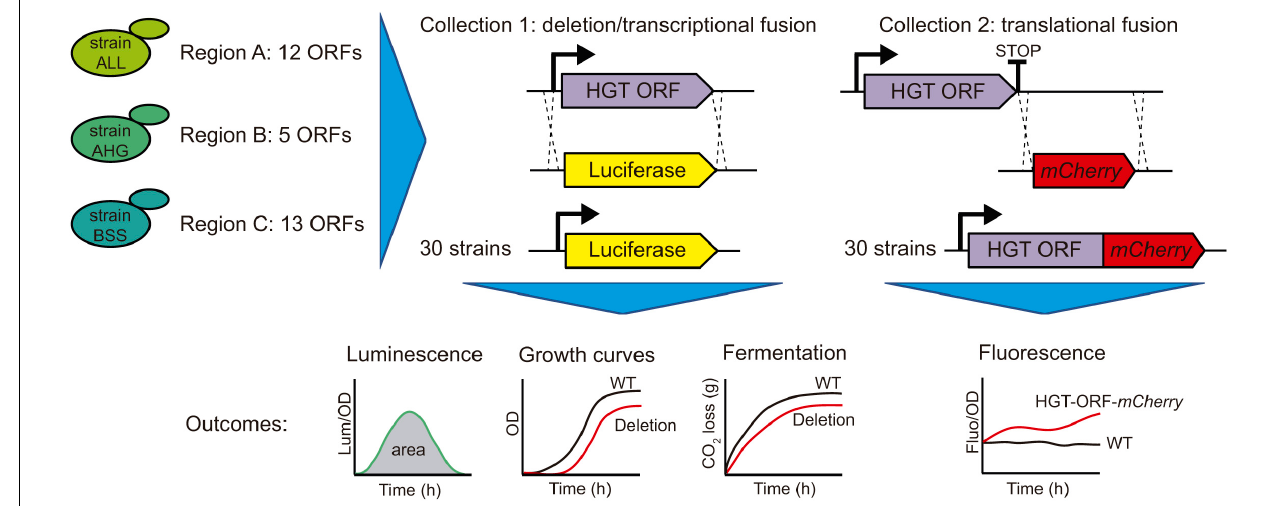
FIGURE 2 | Overview of the molecular characterization of the horizontally acquired regions. In the three selected strains, the ORFs acquired by Horizontal Gene Transfer (HGT) were replaced by the luciferase reporter gene, generating the transcriptional fusion of the promoter region and deletion of the target gene (Collection 1). This collection was assayed for luciferase expression, kinetic parameters using growth curves and fermentation kinetics by laboratory scale fermentations. Similarly, the stop codon of the target genes was replaced by the mCherry fluorescent protein, generating a translational fusion (Collection 2). This collection was assayed for mCherry fluorescent protein